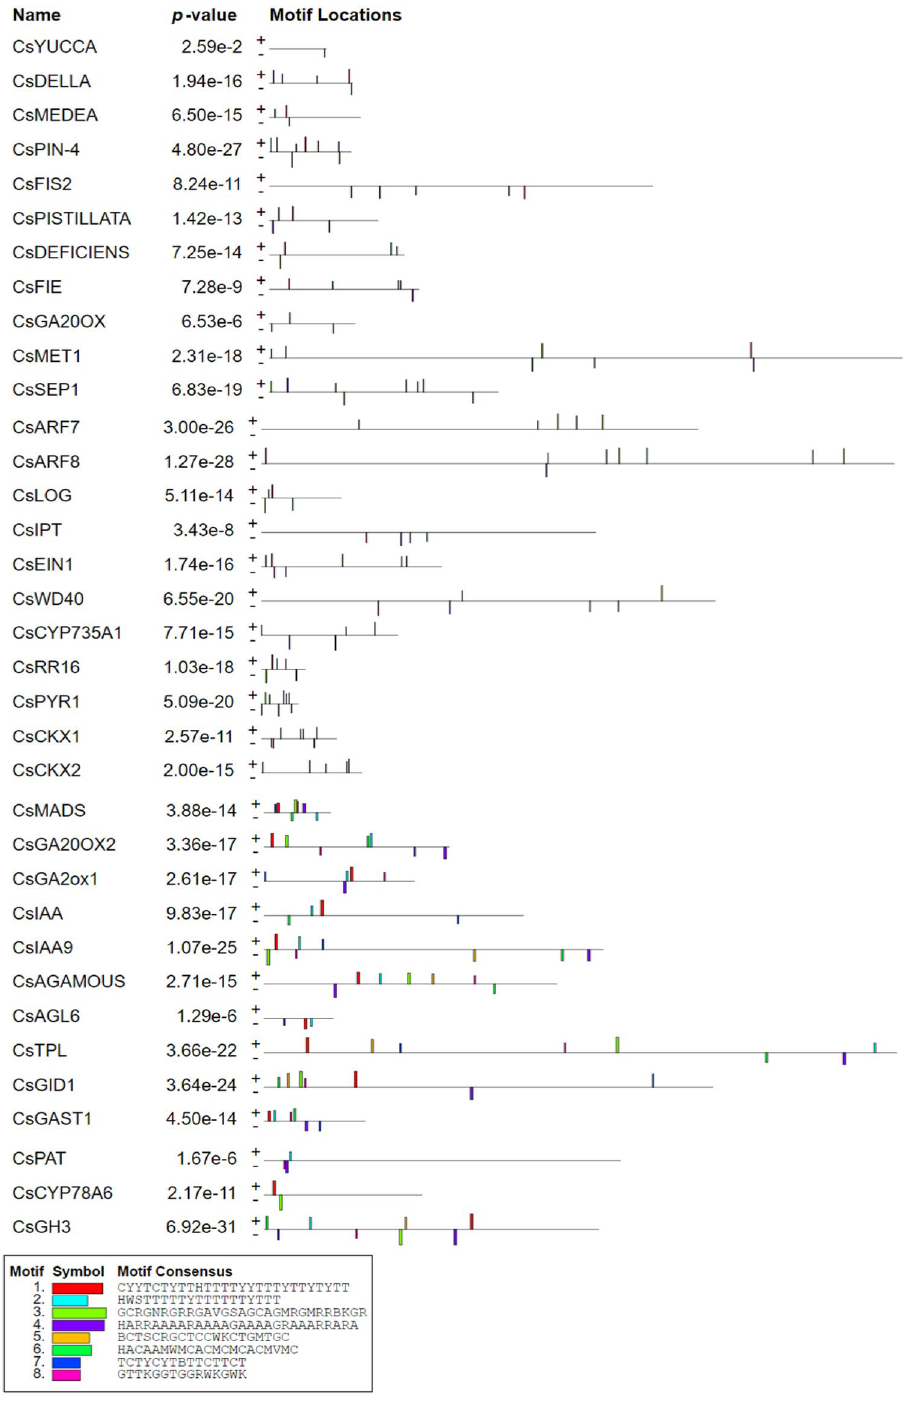
Figure 4. Conserved motifs in nucleotide sequences of PRGs in cucumber predicted using MEME suite. Different motifs are shown in different